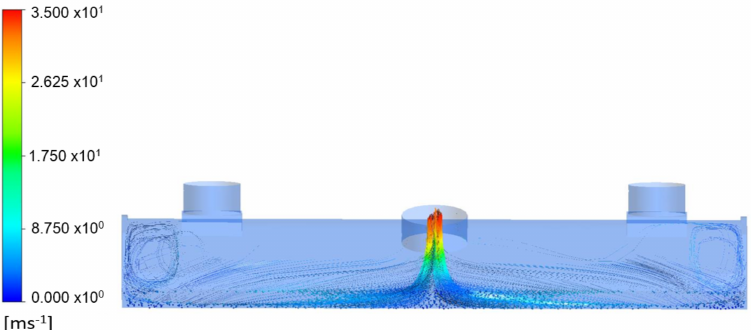
Figure 7. Velocity and trajectory of particles moving through the suction